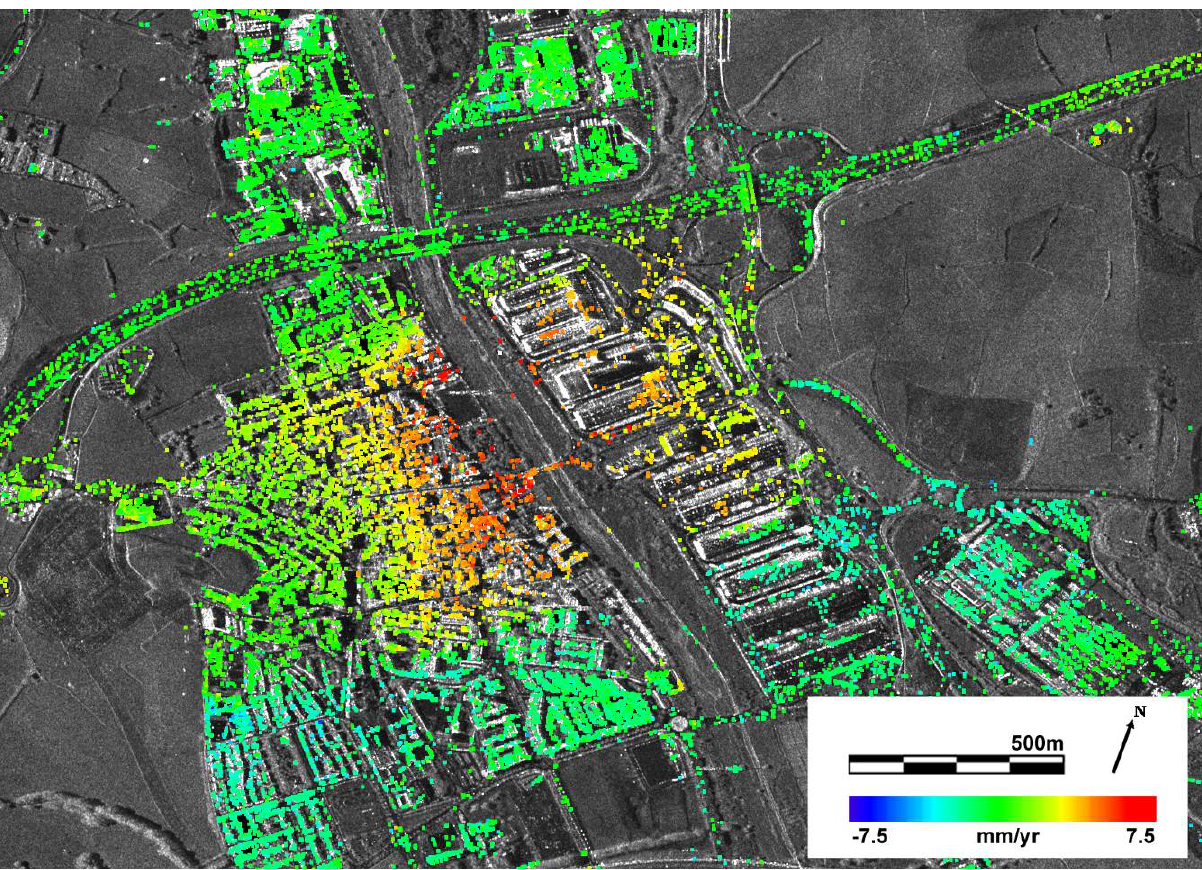
Figure 2: Example of terrain deformation caused by water abstraction. The deformation velocity is superposed to a mean SAR amplitude